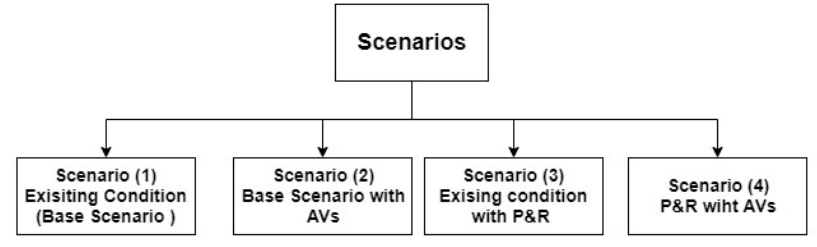
Figure 1. Simulation scenarios of work and shopping travelers.